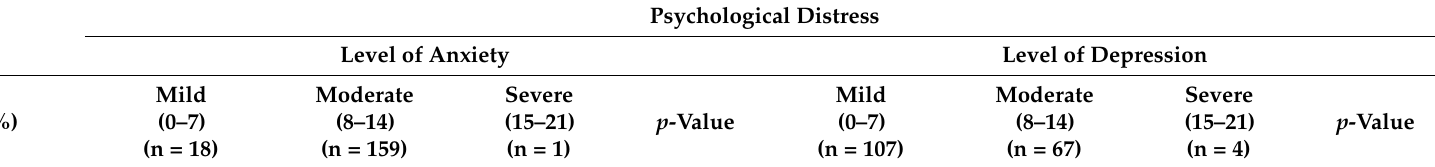
Table 2. Association between demographic characteristics and psychological distress (anxiety and depression) (N =